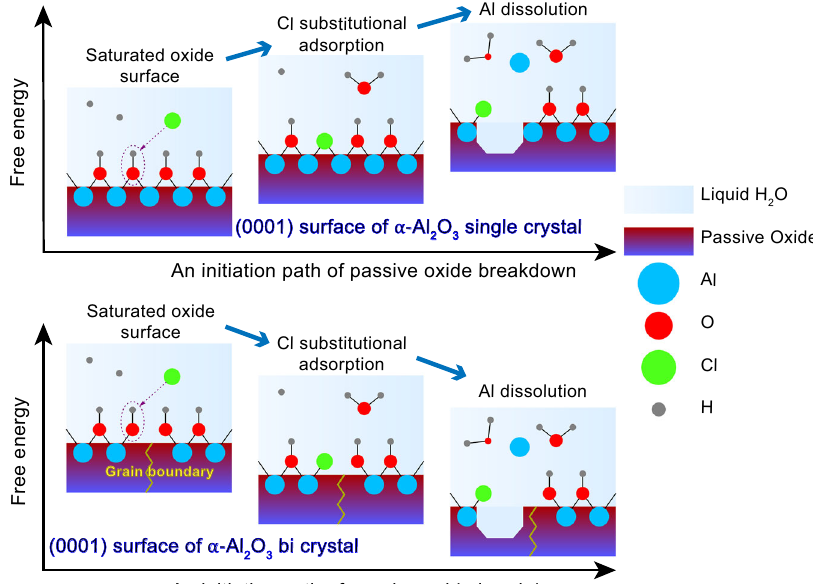
Fig. 1 Illustration of the major conclusion of this study. Under aqueous electrochemical conditions, the stable (0001) surfaces of α -Al 2 O 3 are saturated with surface hydroxyl (OH). Cl can be stabilized on these surfaces only by substituting OH. This substitutional adsorption process is endothermic (thermodynamically unfavorable) on the single-crystal surface terminations (the top schematic). The adsorption process is exothermic (thermodynamically favorable) only on defect sites such as grain boundary surface terminations (the bottom schematic). The following Cl-induced Al dissolution from the passive oxide could also be exothermic only at such defect sites (the bottom schematic). A key difference between the single-crystal surface (the top schematic) and the defect sites (the bottom schematic) is the coordination number (CN) of adsorbed OH and Cl, which is de fi ned by the number of bonds to the neighbor Al atoms on the